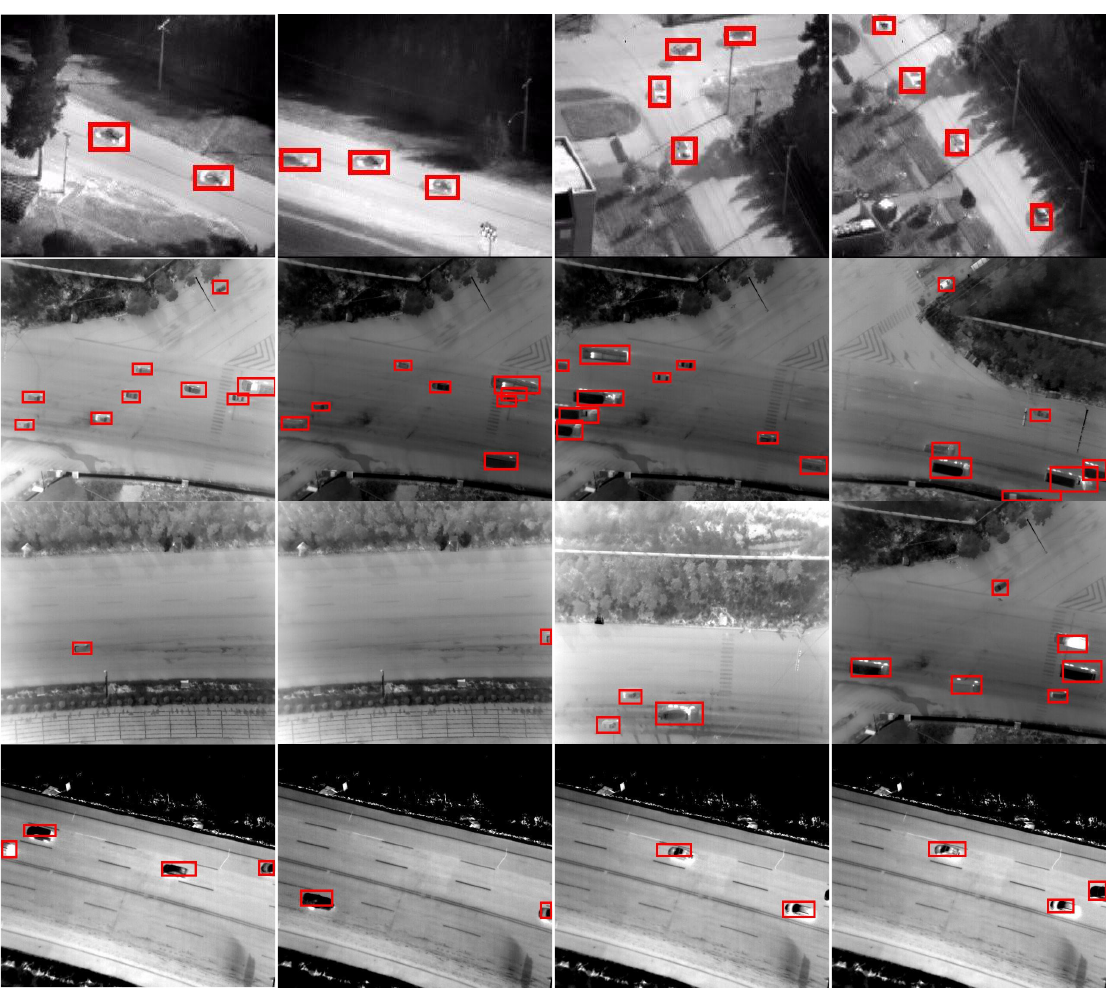
Figure 1. The detection method’s performances on four tests, from top to bottom: VIVID_pktest1 [36], NPU_DJM100_1, NPU_DJM100_2, Scenes Change